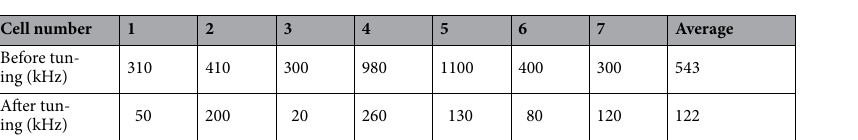
Table 5. Difference between the design frequency and measured one, before and after tuning for π/2